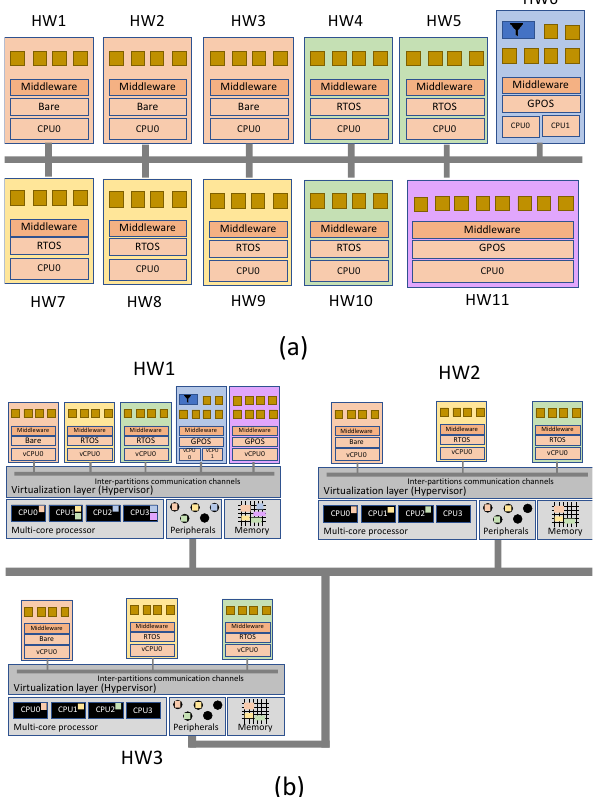
Figure 6. ( a ) Traditional redundancy management. ( b ) Redundancy management in a virtualization context.